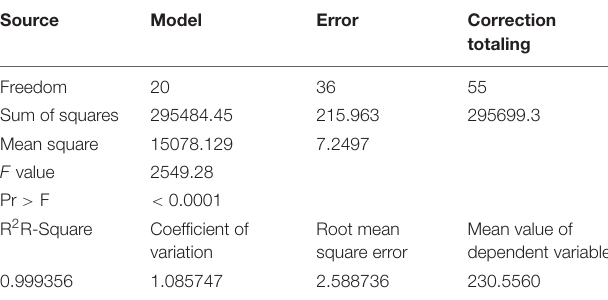
TABLE 2 | Two factor variance analysis of unit biogas